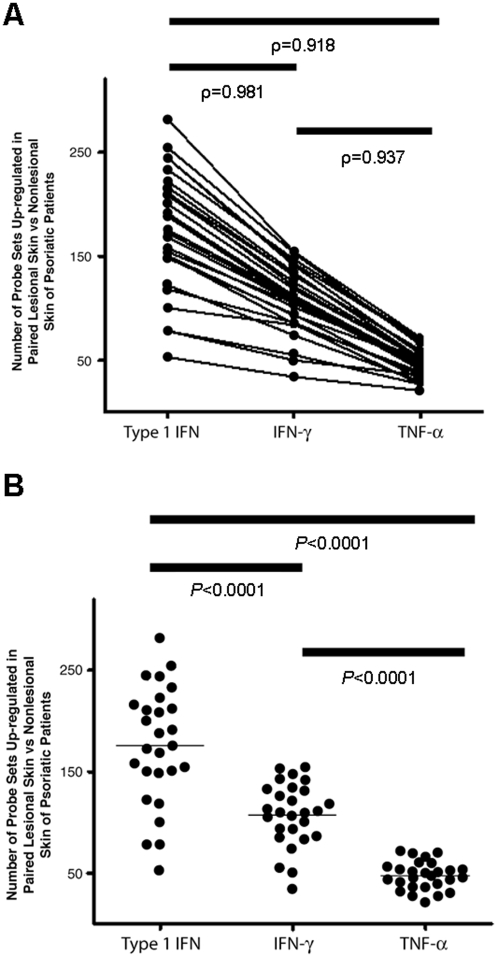
Co-overexpression of type I IFN, IFN-γ and TNF-α–inducible genes.Paired lesional and nonlesional skin of psoriatic patients was analyzed with Affymetrix Genechip®. The type I IFN, IFN-γ and TNF-α–inducible genes were selected based on healthy donor whole blood ex vivo stimulation with these cytokines. A probe set with fold change of ≥2 in lesional skin compared with its paired nonlesional skin is considered overexpressed in the specific lesional skin. A, The number of up-regulated type I IFN–, IFN-γ– and TNF-α–inducible genes in lesional skin compared with paired nonlesional skin shows a strong correlation (ρ = Pearson's correlation coefficient) from pairwise comparisons. B, The numbers of type I IFN–, IFN-γ– and TNF-α–inducible genes in lesional skin compared with nonlesional skin are significantly different as evident from pairwise comparisons. The horizontal bars represent the median value for each group.